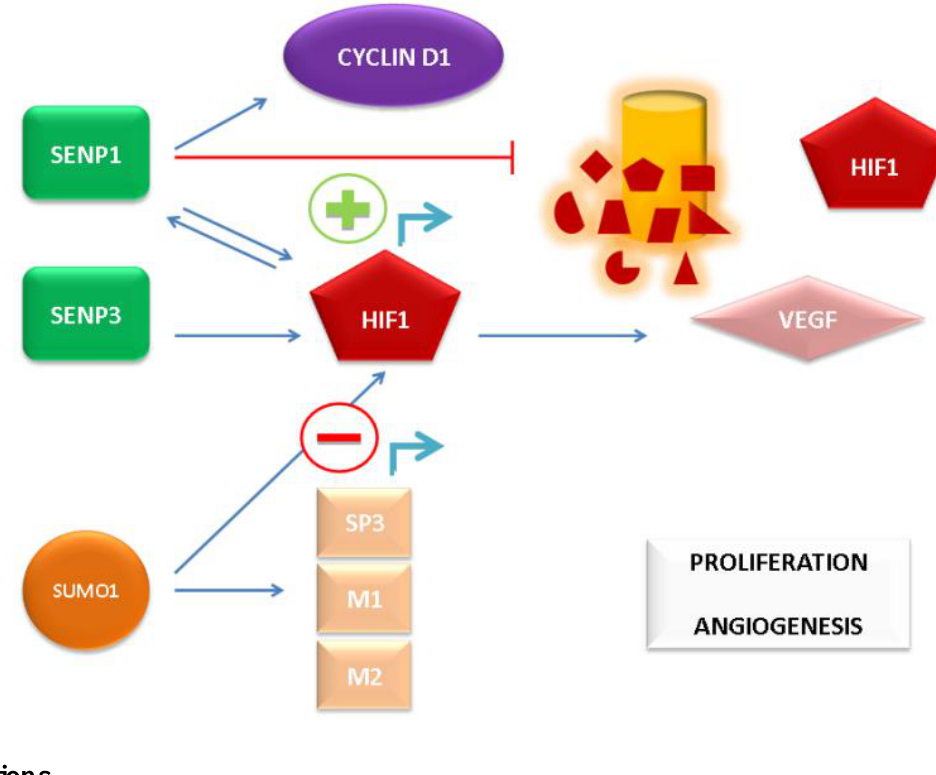
Figure 2. AR-independent promotion of prostate cancer (PCa) cell proliferation and angiogenesis by the SUMO